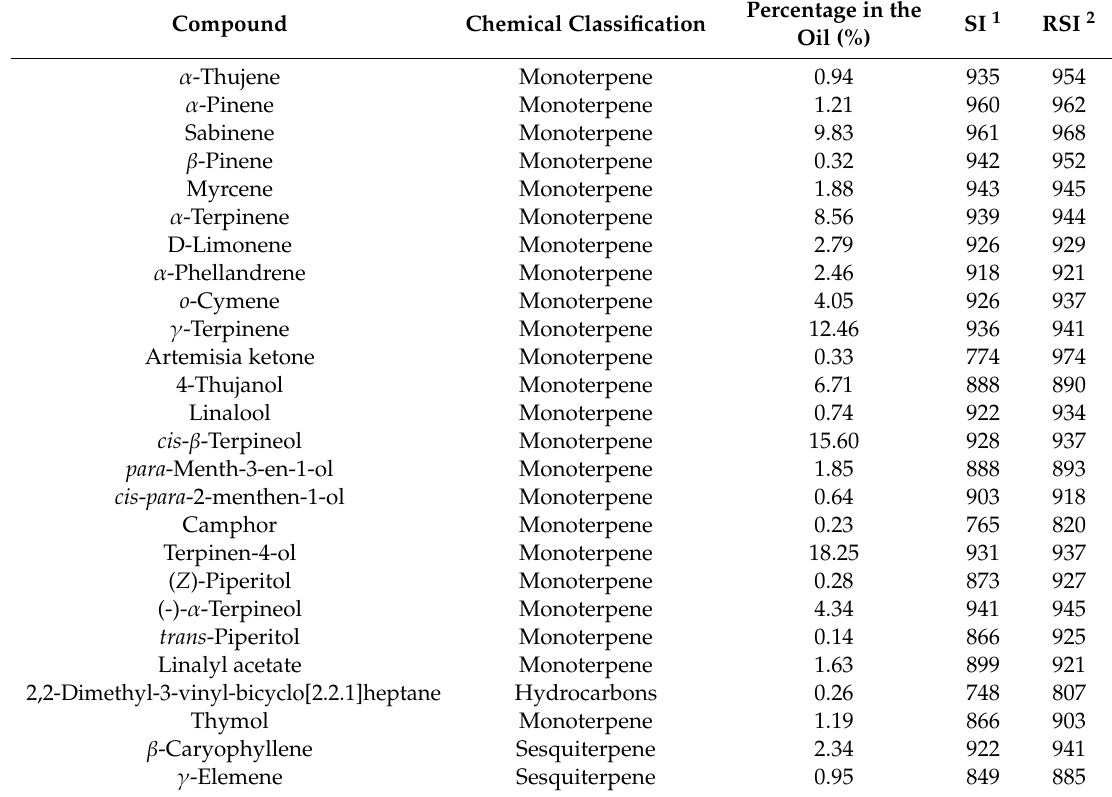
Table 2. Phytochemicals of essential oil from S. terebinthifolius branches by gas chromatography-mass spectrometry (GC-MS).